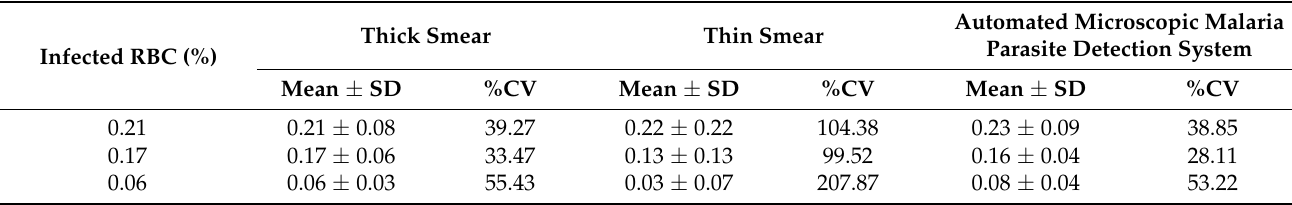
Table 2. Precision of parasitemia measured with PB smears and the automated microscopic malaria parasite detection system using P. vivax -positive patient samples for various levels of parasitemia.